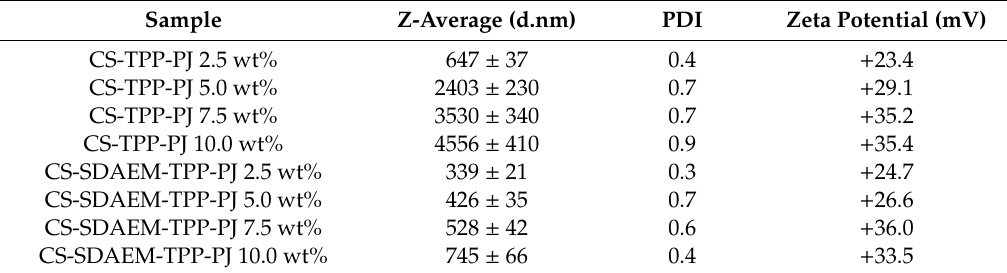
Table 2. Nanoparticles size, polydispersity index (PDI) and zeta-potential results.